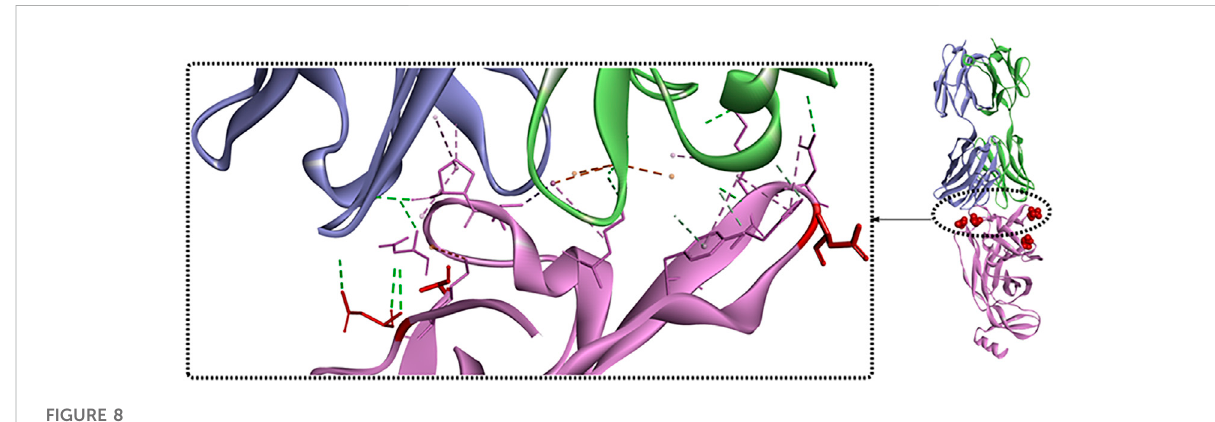
FIGURE 8 Crystal structure analysis of S-NTD bound to S2M28 Fab